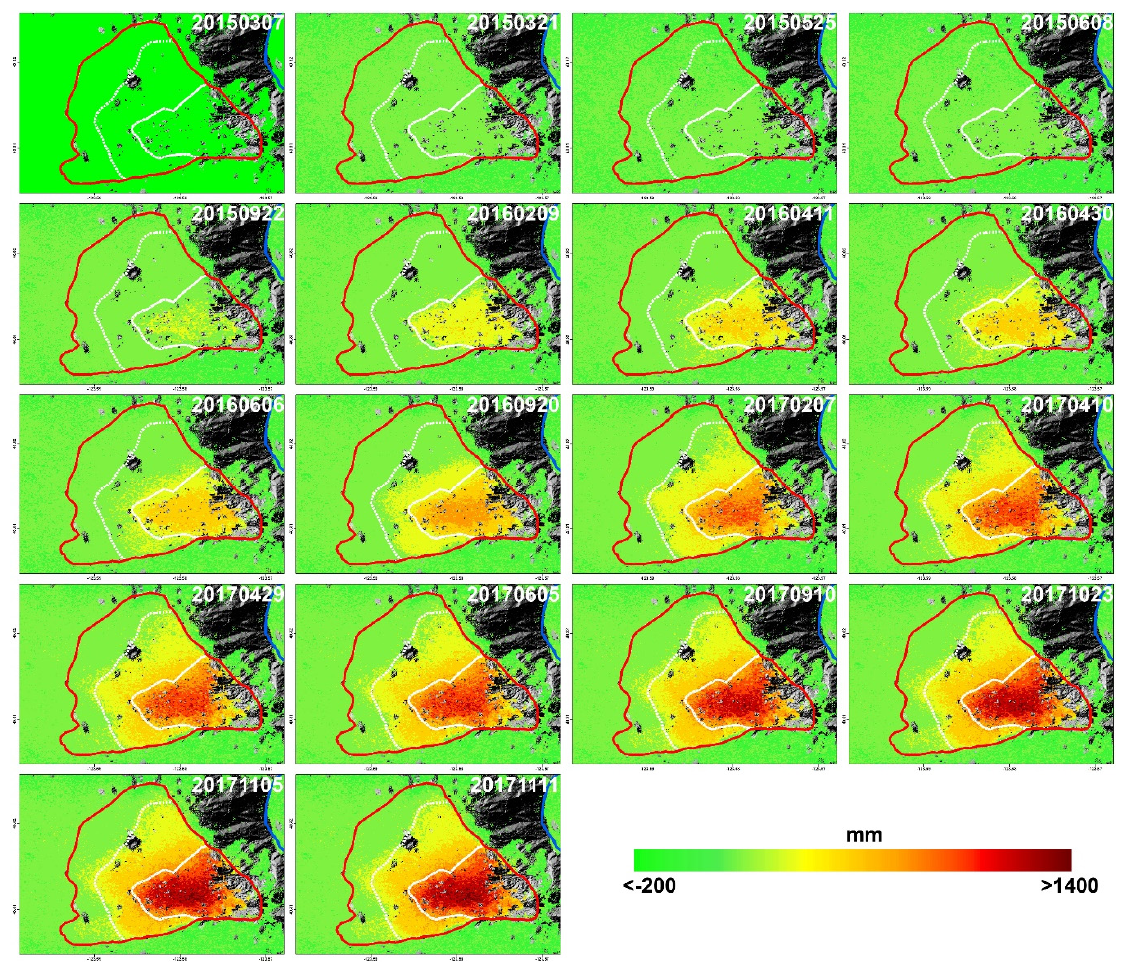
Figure 8. Cumulative east–west deformation from 7 March 2015 to 11 November 2017 inverted by using ascending and descending ALOS PALSAR-2 satellite datasets. It is worth noting that the positive values indicate eastward movement while the negative values represent westward movement.